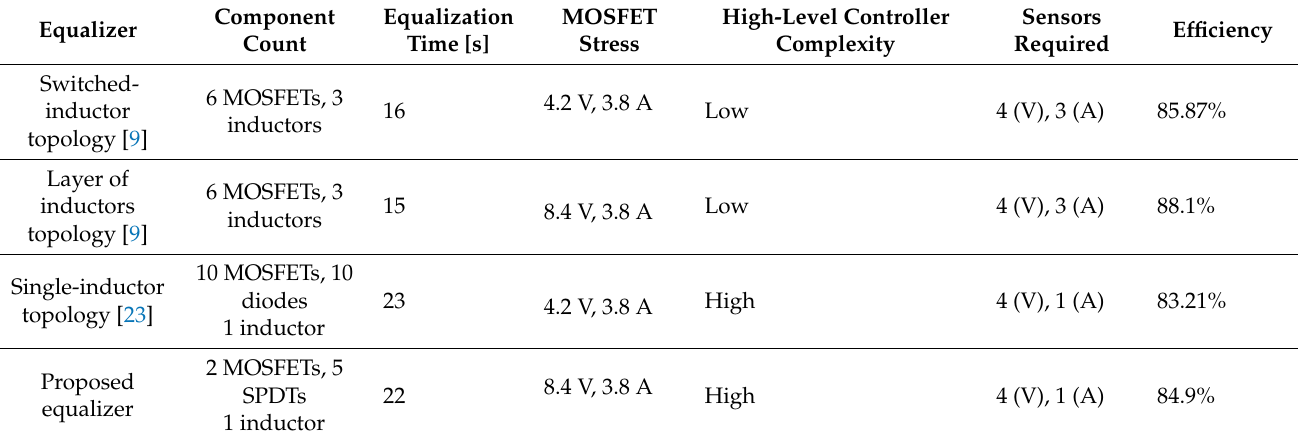
Table 5. Comparative analysis of the reviewed equalizers for a four-cell battery bank